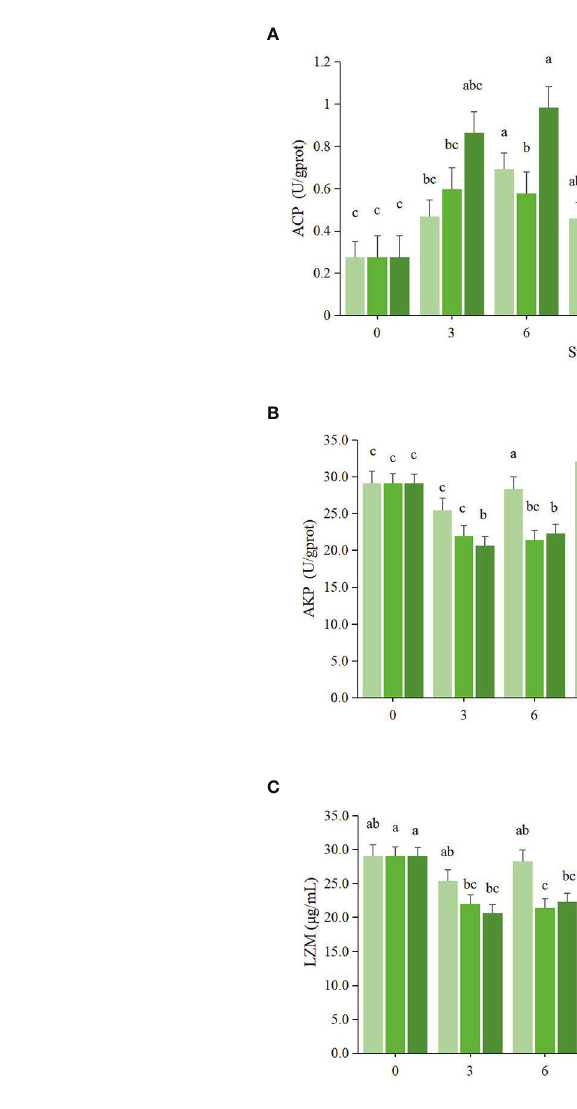
FIGURE 3 Changes of immune enzyme activities in hepatopancreas of C sinensis at different time points after different residual chlorine stress. (A) ACP activitiy, (B) AKP activitiy and (C) LZM activitiy. Different letters indicate statistically signi fi cant differences between different time points for the same treatment using one-way ANOVA and Tukey ’ s comparison of the means test ( P <